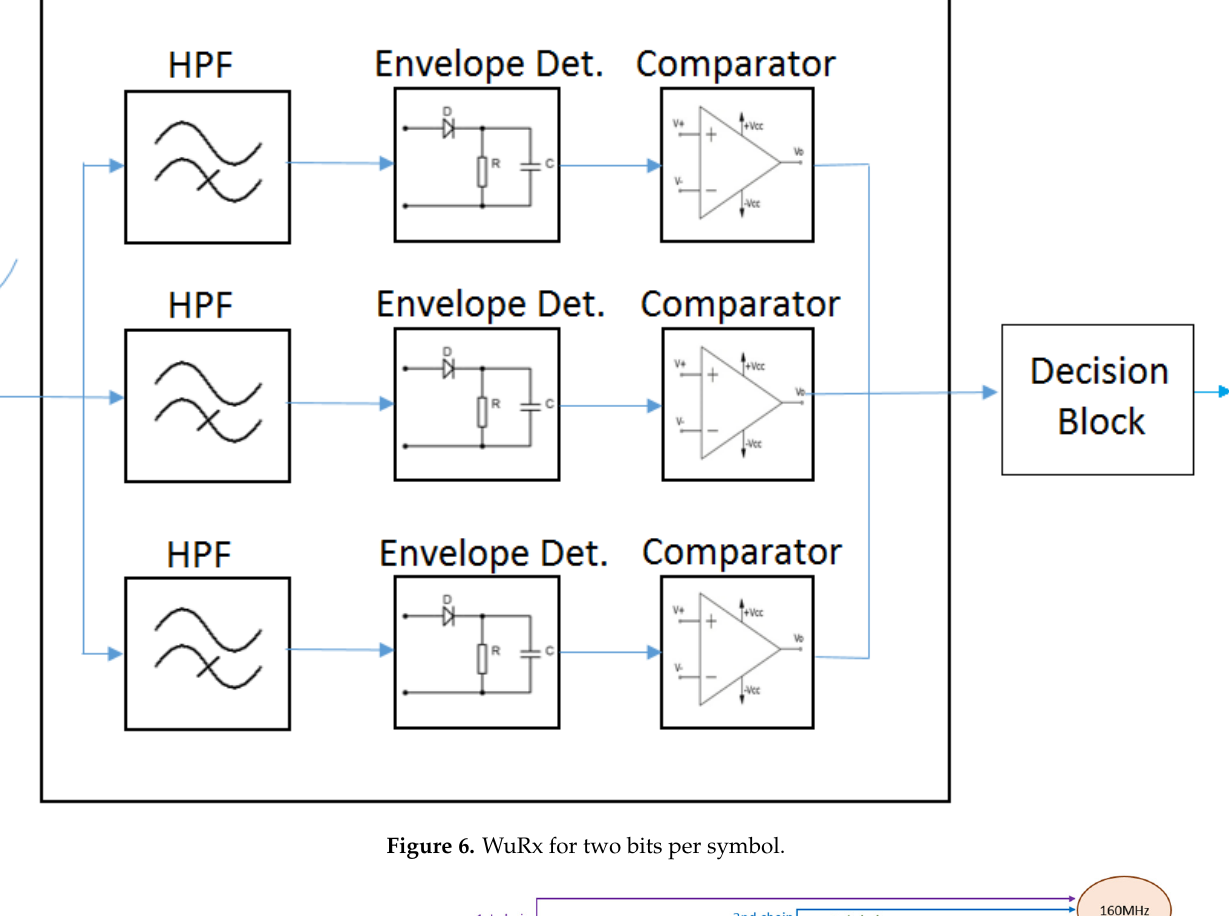
Figure 5. Main composition of WuRx.